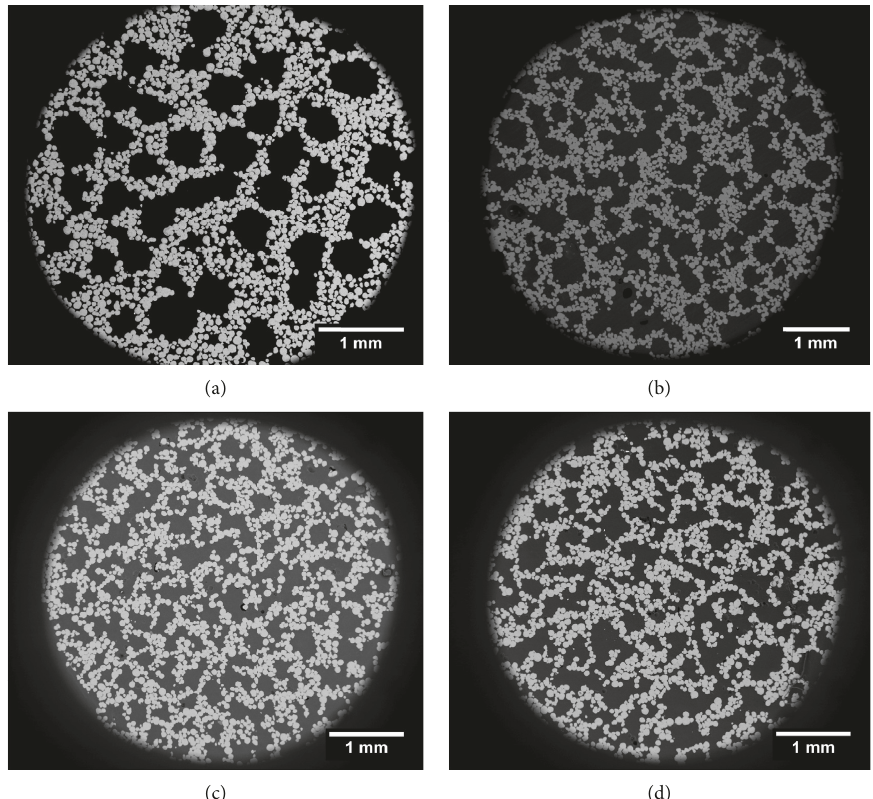
Figure 10: SEM images of (a) Ti foam made using SP607 space holder, (b) Ti foam made by SP380 space holder, (c) Ti foam made by CU336, and (d) Ti foam made by CU381. Table 1: Average pore diameter in the Ti foams produced. Feedstock used